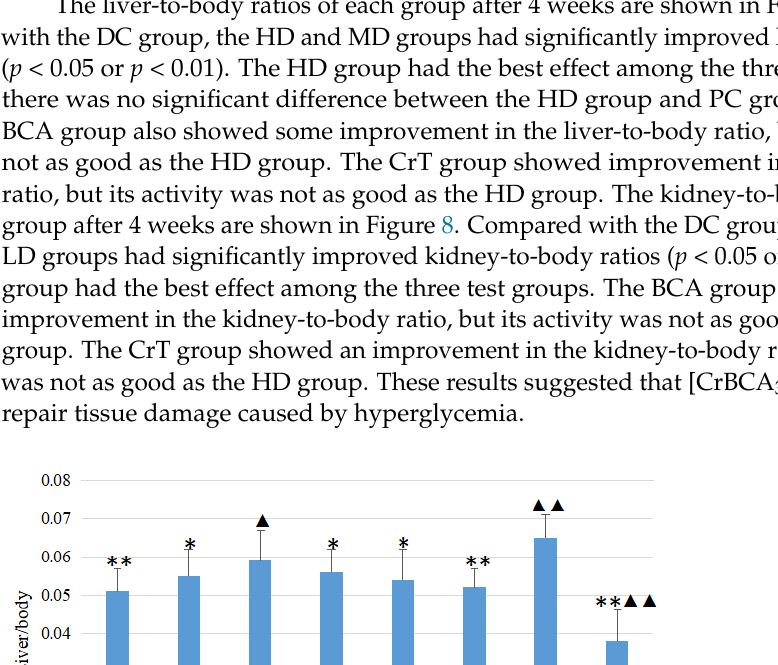
Figure 8. The kidney/body ratio after 4 weeks. Values are means ± SD ( n = 7). The differences be- tween these groups and the DC group were statistically significant (denoted by “*” for p < 0.05, “**” for p < 0.01); the differences between these groups and the PC group were statistically significant (denoted by “ ▲ ” for p < 0.05, “ ▲▲ ” for p < 0.01). 2.2.5. Comparison of OGTT After 4 weeks, the OGTT results for each group were obtained (Figure 9). The glucose tolerances of the HD group and PC group were better than that of the DC group after 1 h of glucose administration ( p < 0.05). The glucose tolerances of the HD, BCA, CrT and PC groups were better than that of the DC group after 2 h of glucose administration ( p < 0.05). This indi- cated that [CrBCA 3 ] could improve the glucose tolerance of db/db mice.